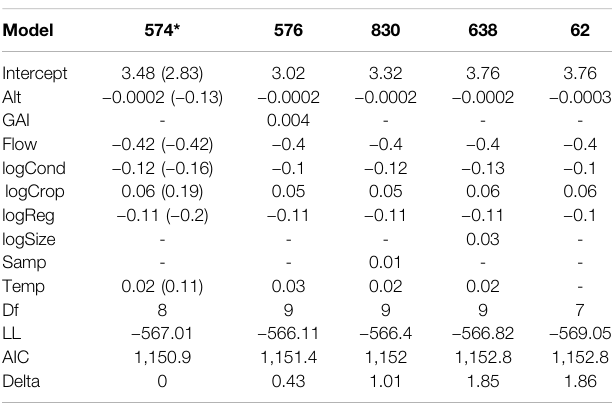
TABLE 2 | AIC model selection with regression estimates for the included environmental variables (altitude (Alt), Global Aridity Index (GAI), intermittent fl ow regime (Flow), conductivity (log-transformed; logCond), cropland extent (log- transformed; logCrop), degree of regulation (log-transformed; logReg), river size (log-transformed; logSize), number of samples per site (Samp), water temperature (Temp)), degrees of freedom (Df), Log-likelihood (LL), information score ofthemodel (AIC), delta and AIC weight forall models within adelta of2 (* (cid:1) fi nal model). Regression estimates with standardized variables are indicated in brackets for the fi nal